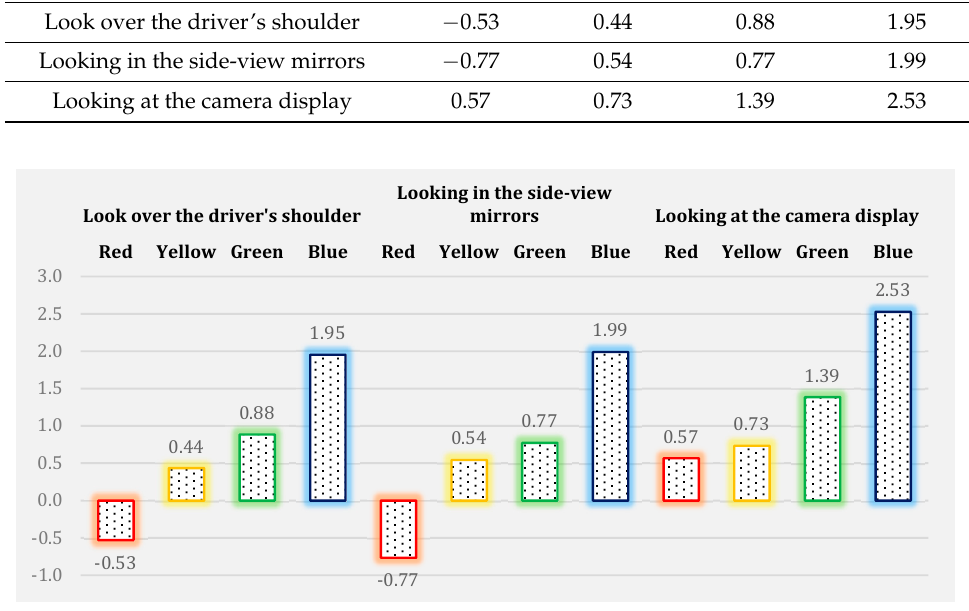
Figure 7. The mean error of the estimation of distance to the object for all conditions and all colors.